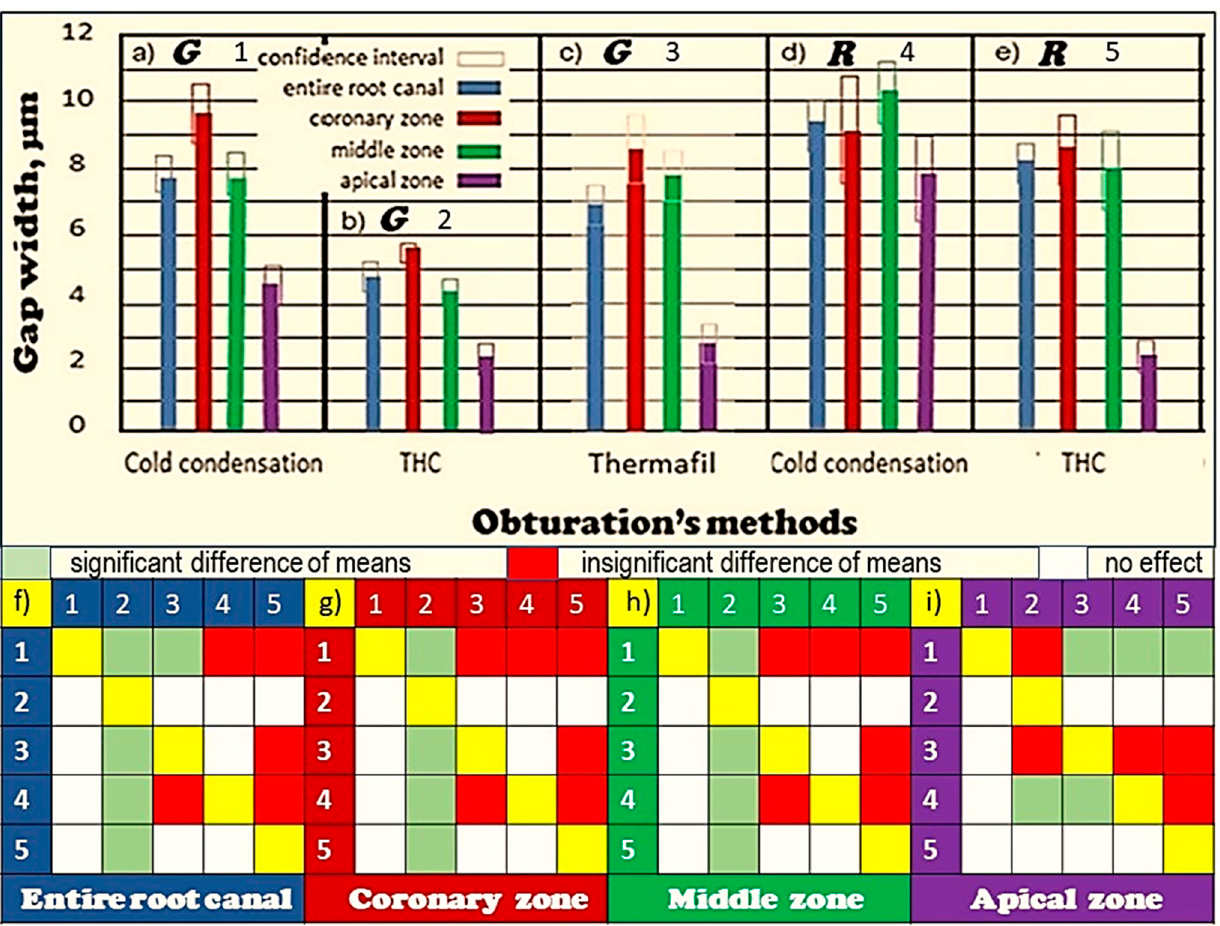
Figure 30. Generalization of the measurement results: ( a – c ) statistical analysis of the measurement results of the gap between the sealant and dentin of root canals filled with gutta-percha-based material ( a – c ) (1–3) and resilon ( d , e ) (4,5) after filling with the following methods: ( a , d ) cold; ( b , c , e ) thermoplastic method using: ( b , e ) THC; ( c ) Thermafil; ( f – i ) a summary of the significance level of the differences between the average width of the gaps for the studied groups: ( f ) entire root canal; ( g ) coronary zone; ( h ) middle zone; ( i ) apical zone.